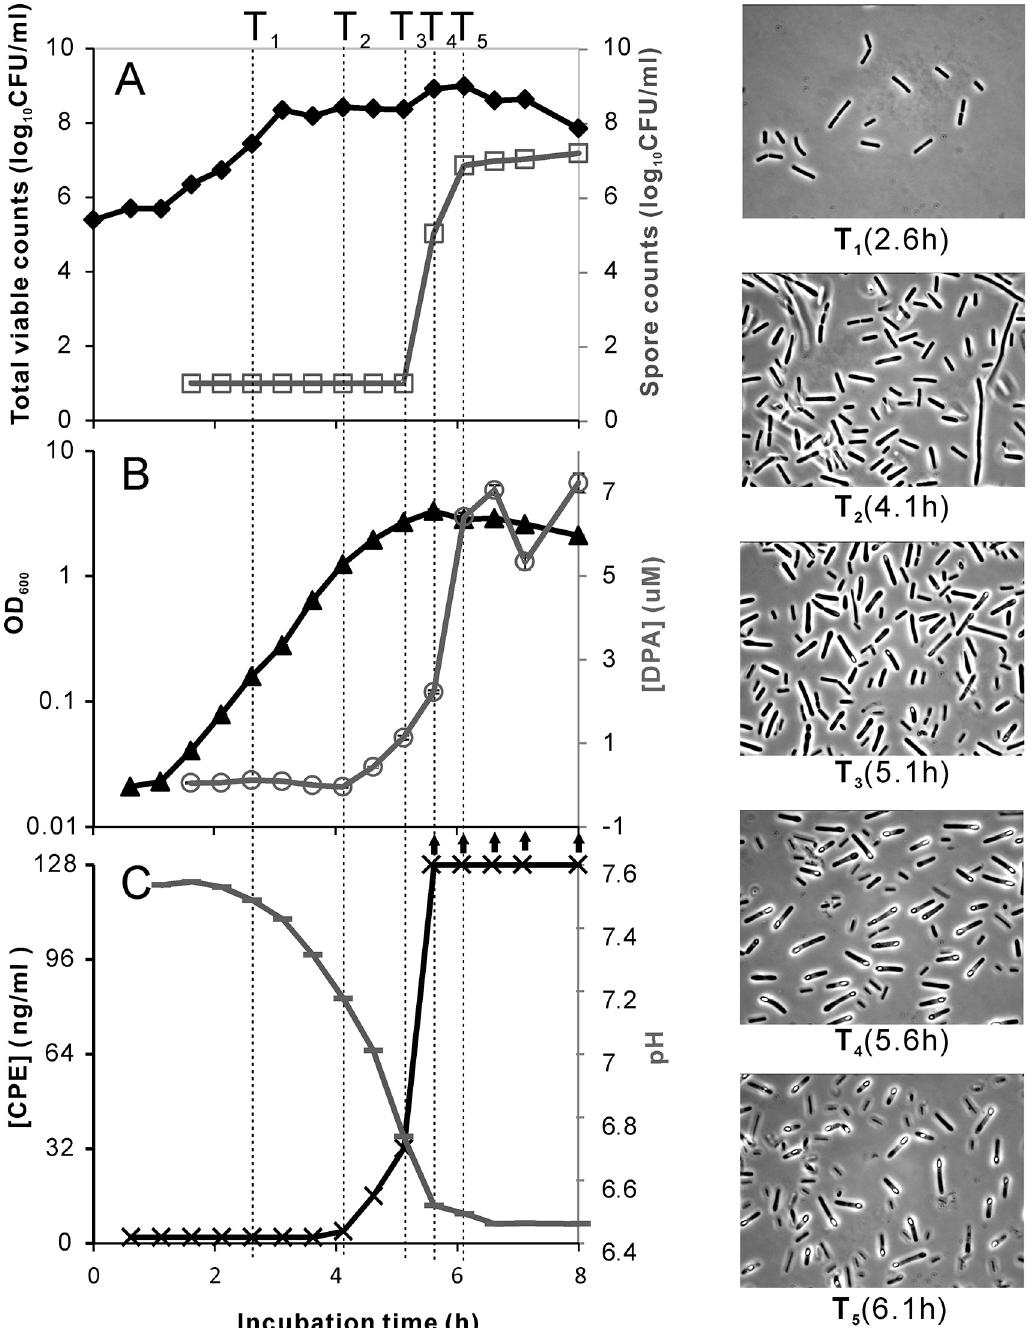
Fig 1. Analysis of a sporulating culture of C . perfringens SM101. In the culture growing in mDS, the following parameters were determined in time: biomass accumulation (OD 600 ), the total viable counts of cells plus spores, the viable count of heat resistant spores alone, the pH of the supernatant, CPE production and DPA accumulation. Phase contract microscopic images were taken at representative time points of five phases (magnification: 1000×). Fig 1A shows total viable counts ( ♦ ) and spore counts ( □ ); B shows OD 600 ( ▲ ) and DPA accumulation in forespores/spores ( (cid:1) ); C shows pH (-) and CPE in supernatant ( × ) * . * The detection range of the PET-RPLA was 2 to 128 ng/ml. Samples with CPE concentrations exceeding 128 ng/ml are indicated with an arrow pointing